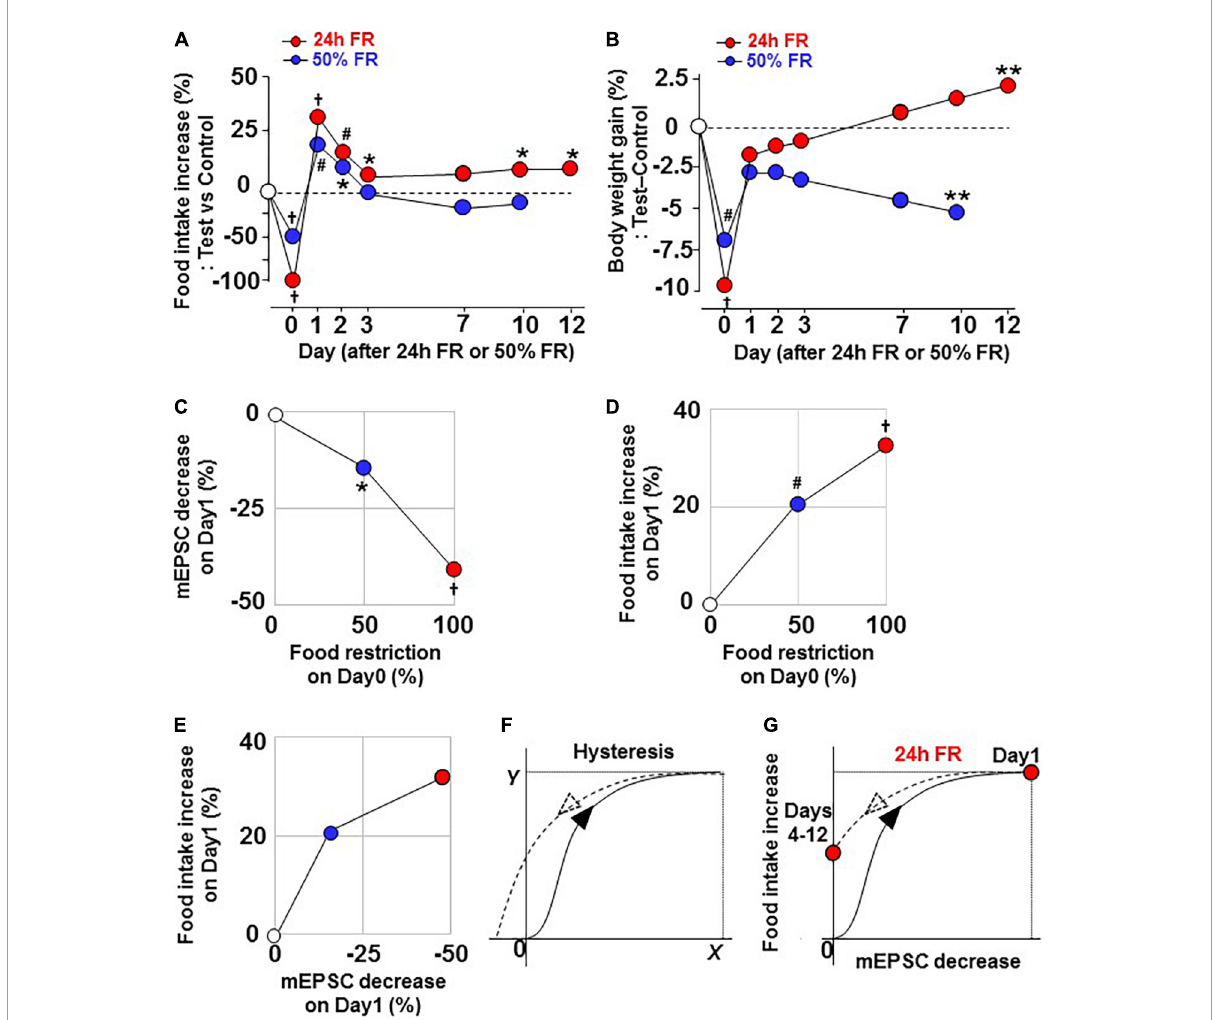
FIGURE8 Twenty four hours FR, but not 50% FR, induces rebound through hysteresis in the ‘miniature excitatory postsynaptic current inhibition—hyperphasia’ relationship. Data are re-plotted from Figures 2A,C , 7A,C . (A,B) Comparable effects of 24 h FR and 50% FR on changes in daily food intake (A) and body weight gain (B) . Twenty four hours FR, but not 50% FR, induced increases in daily food intake and body weight gain on Day 10 and later. (C , D) Relationship of food restriction (%) on Day 0 to mEPSC decrease (%) on Day 1 (C) and to food intake increase (%) on Day 1 (D) . (E) Relationship between mEPSC decrease (%) on Day 1 and food intake increase (%) on Day 1. (F) Hysteresis, in the “ X–Y” relationship. (G) Hysteresis, presumed in the “mEPSC decrease–food intake increase” relationship and consequent upward shift of food intake on Days 4–12 after 24 h FR. * P < 0.05, ** P < 0.01, # P < 0.001, and † P < 0.0001 between 24 h FR or 50% FR vs. fed groups by two-way ANOVA followed by post-hoc Sidak’s